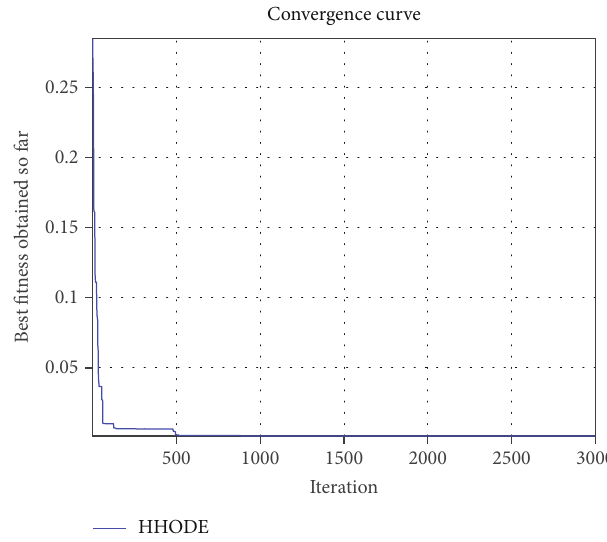
Figure 5: Convergence curve of RMSE.